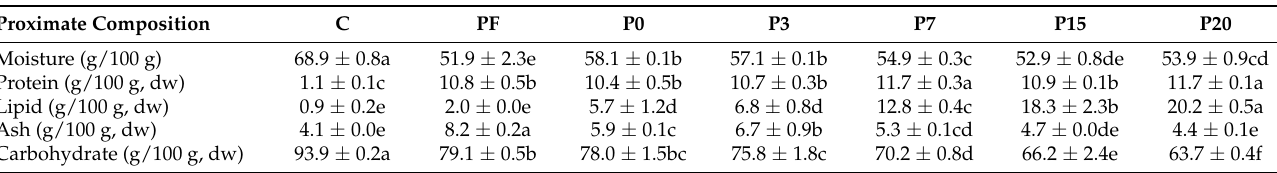
Table 2. Proximate composition of experimental